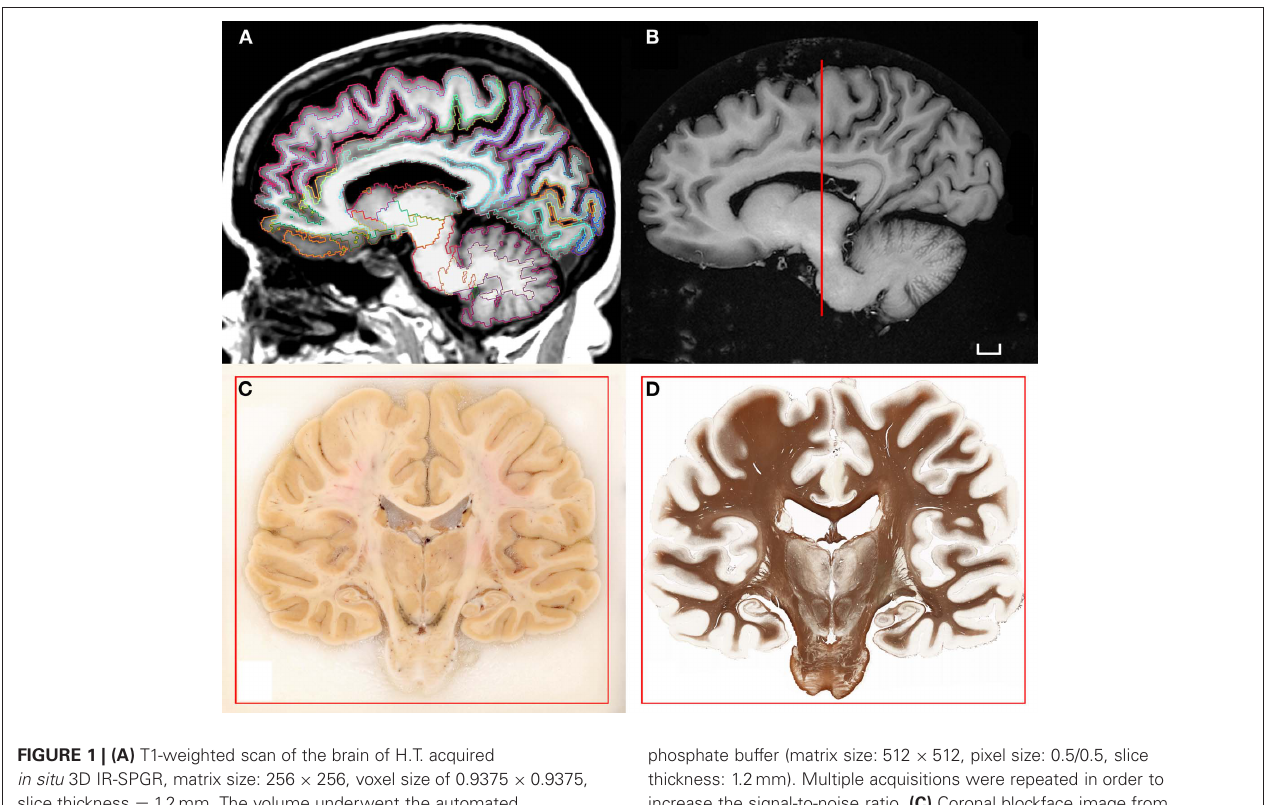
FIGURE 1 | (A) T1-weighted scan of the brain of H.T. acquired in situ 3D IR-SPGR, matrix size: 256 × 256, voxel size of 0.9375 × 0.9375, slice thickness = 1.2mm. The volume underwent the automated labeling of subcortical structures and cortical gyri that is part of the morphometry pipeline included in the software Freesurfer (Fischl et al., 2002, 2004). (B) High-resolution T1-weighted scan of the formalin-fixed specimen imaged ex situ . The brain was scanned in a dedicated chamber filled with